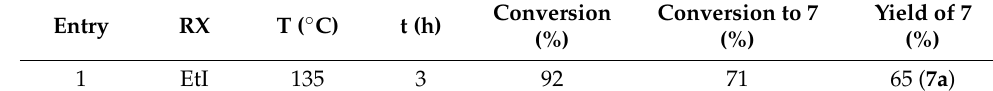
Table 4. Alkylating esterification of dibutylphosphate ( 2a ) with alcohols under MW conditions.